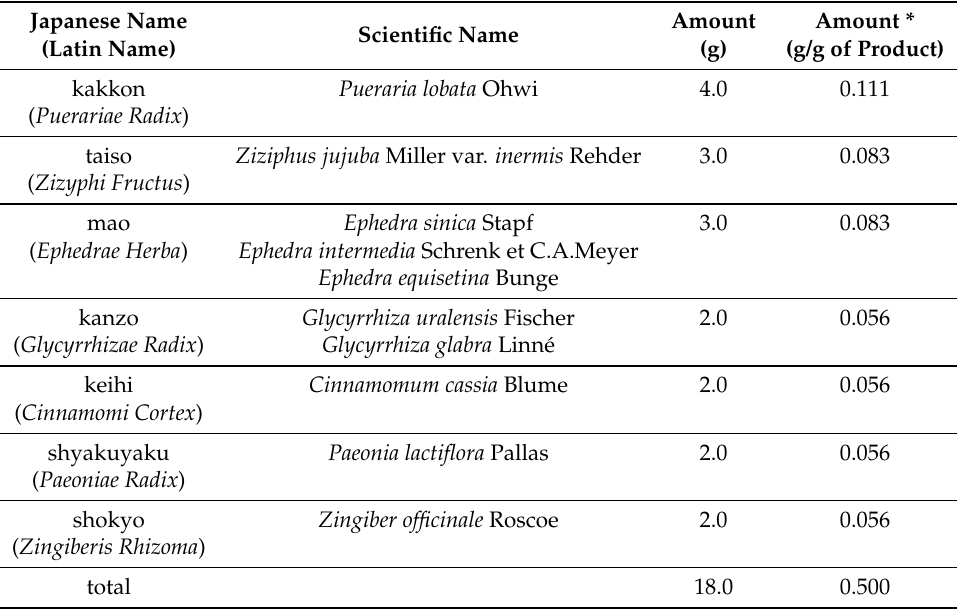
Table 2. The ingredients in the kakkonto (TJ-1) formula.